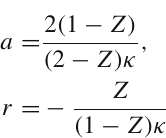
The pole positions in the first and second RS’s are